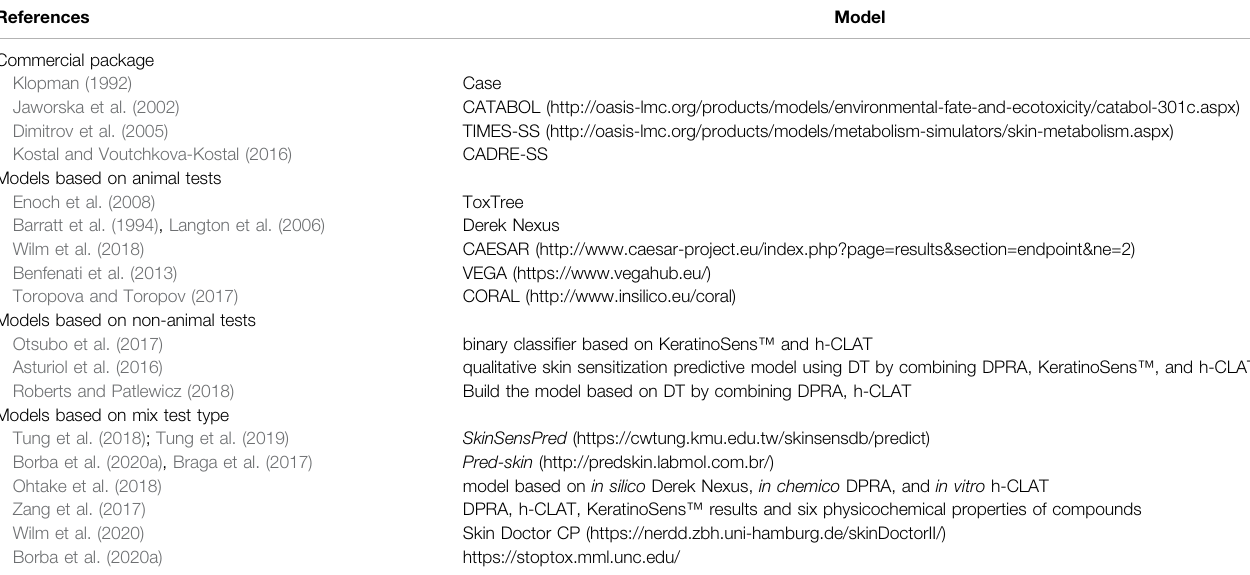
TABLE 7 | The commercial package and models based on animal, non-animal tests, and mixed test